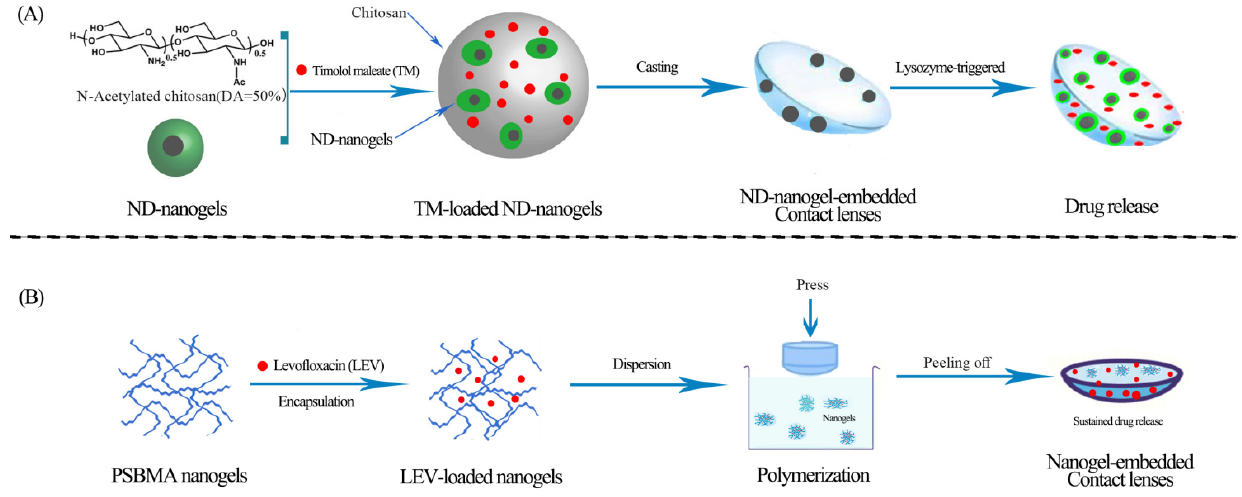
Figure 6. Flowchart for the preparation of two types of drug-loaded nanogel contact lenses ( A ) Nan- odiamond (ND) nanogels are crosslinked with chitosan and loaded with timolol maleate (TM), then embedded in a hydrogel and cast into enzyme-responsive contact lenses. The nanogel contact lenses release TM through lysozyme-triggered mechanisms; ( B ) levofloxacin (LEV) is encapsulated in poly (sulfobetaine methacrylate) (PSBMA) nanogels to form LEV-loaded nanogels, which are then dis- persed in premonomer solutions, polymerized, and pressed into a mold to obtain nanogel contact lenses that sustain drug